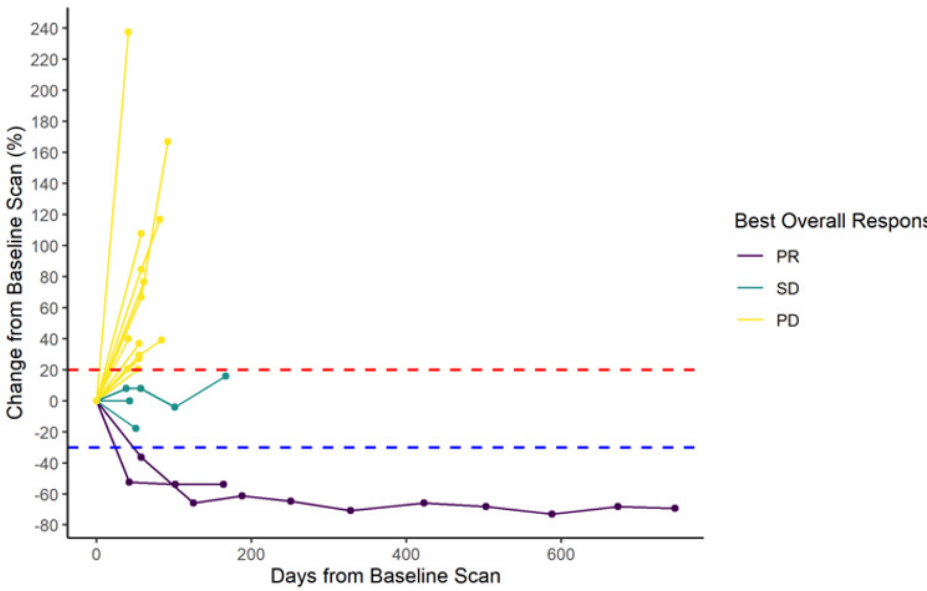
Figure 1. Response to AI plus pembrolizumab (N = 20). Spider plot showing relative change in tumor size from baseline. Each line represents one patient in study. Two patients had partial response (PR), three had stable disease (SD), and 15 had progression of disease (PD). One patient had sustained PR until end of treatment (35 cycles) of pembrolizumab plus exemestane and maintained response on single agent exemestane until data cut-off of July 2021. Red line indicates 20% of increased tumor size per RECIST 1.1. Blue line indicates 30% of reduced tumor size per RECIST 1.1.